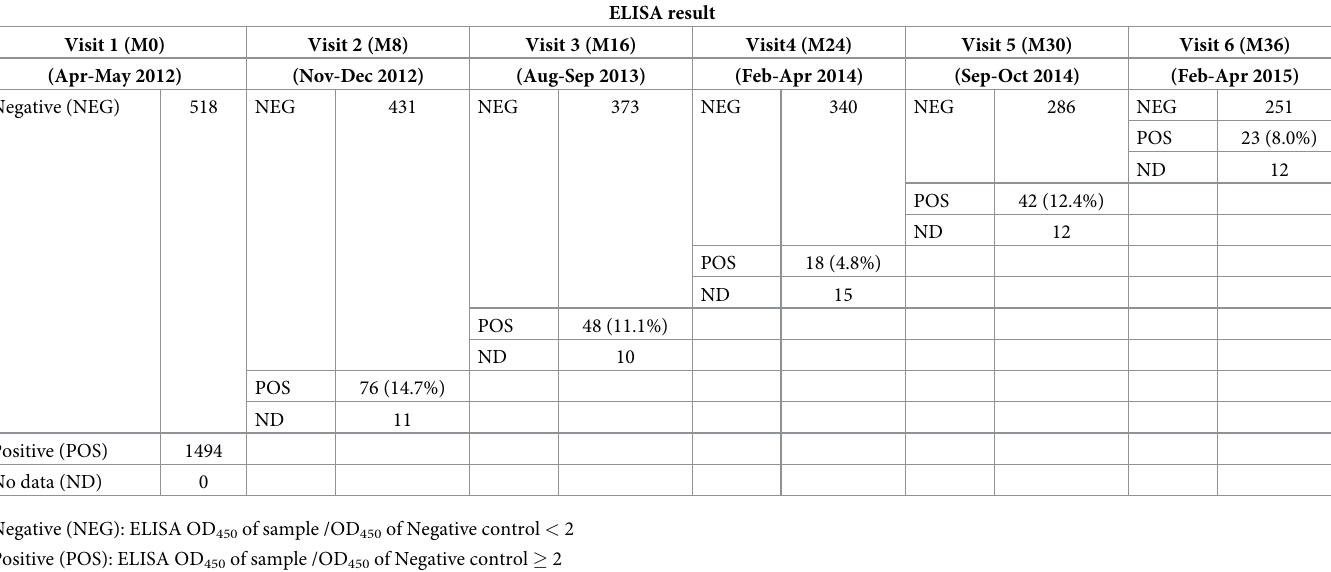
Table 4. Cascade of serostatus information detected by indirect ELISA among seronegative individuals at enrollment.